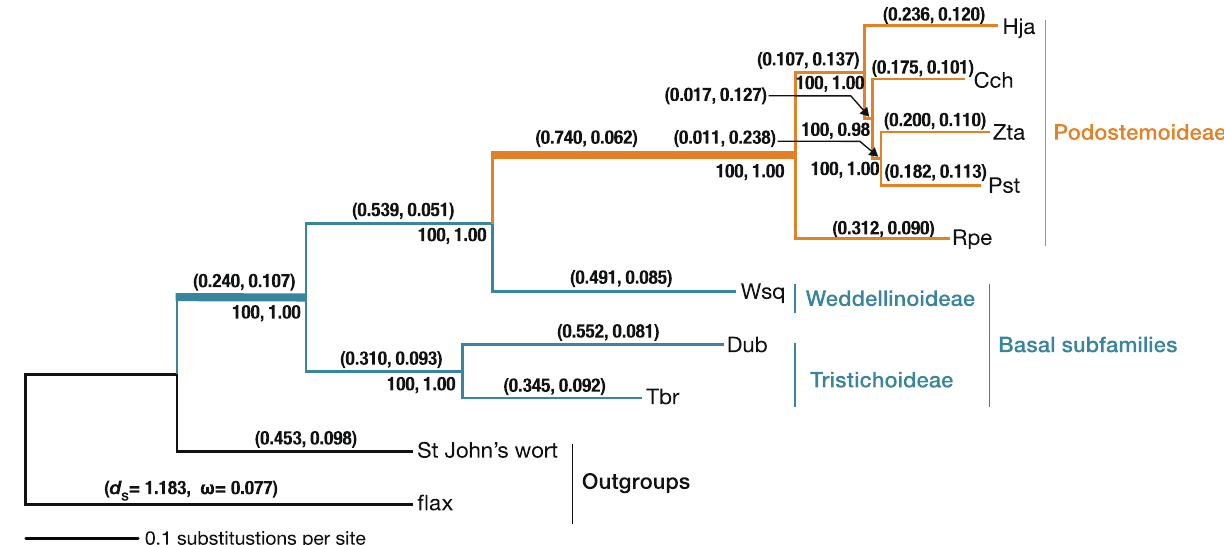
Fig. 2 Phylogenetic tree constructed using multiple sequence alignments of 1640 orthogroups in eight Podostemads, St. John ’ s wort, and fl ax. A maximum-likelihood tree was inferred using RAxML under the GTR + Г + I model. The tree was rooted with fl ax. The branches of Podostemaceae are coloured blue for basal subfamilies (Tristichoideae and Weddellinoideae) and orange for Podostemoideae. Branches featured in gene ontology (GO) enrichment analysis are presented by thick lines. The horizontal lengths are proportional to the estimated number of substitutions per site under the GTR + Г + I model and bootstrap values and posterior probabilities in ASTRAL are shown below branches. The d S and ω ratios are presented within